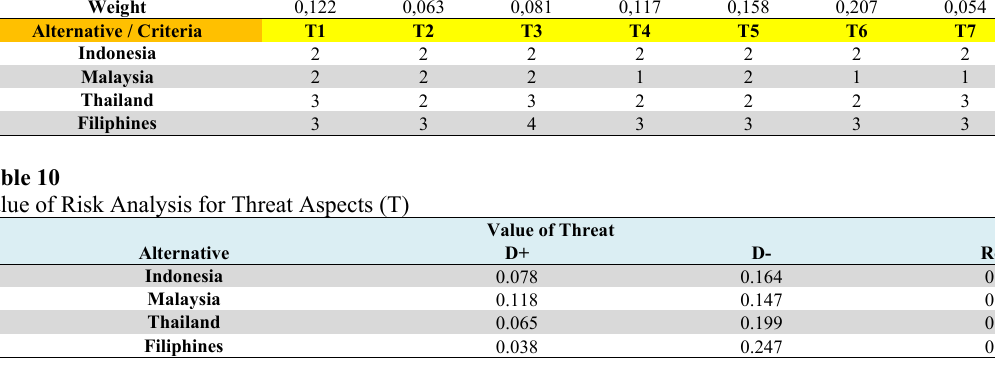
Calculation of the risk analysis matrix for the Threat aspects (T)